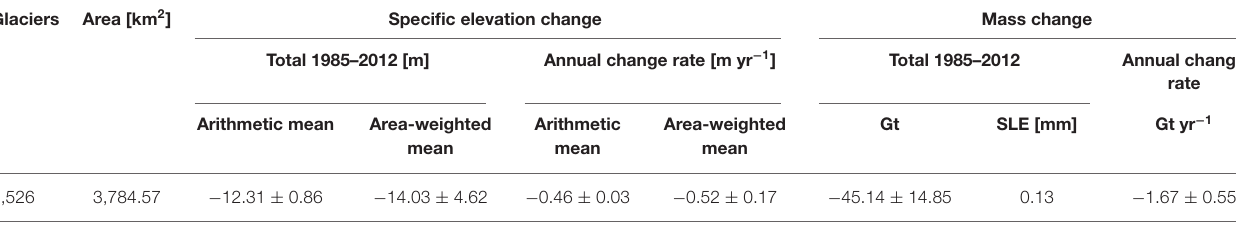
TABLE 2 | Elevation and mass changes of the observed glacier sample in west-central Greenland between 1985 and